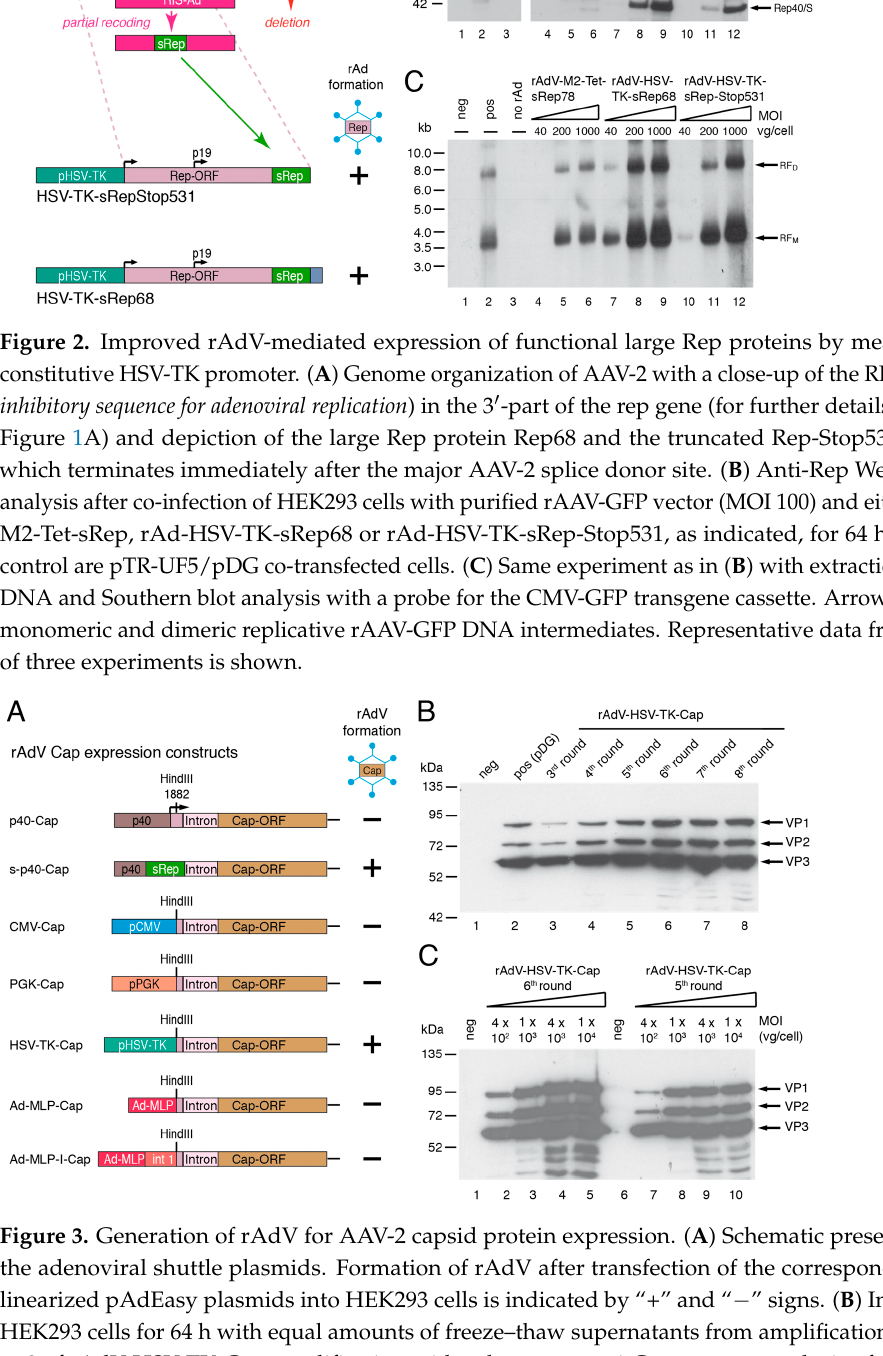
sette. Arrows indicate monomeric and dimeric replicative rAAV-GFP DNA intermediates. Repre- sentative data from a total of three experiments is shown.